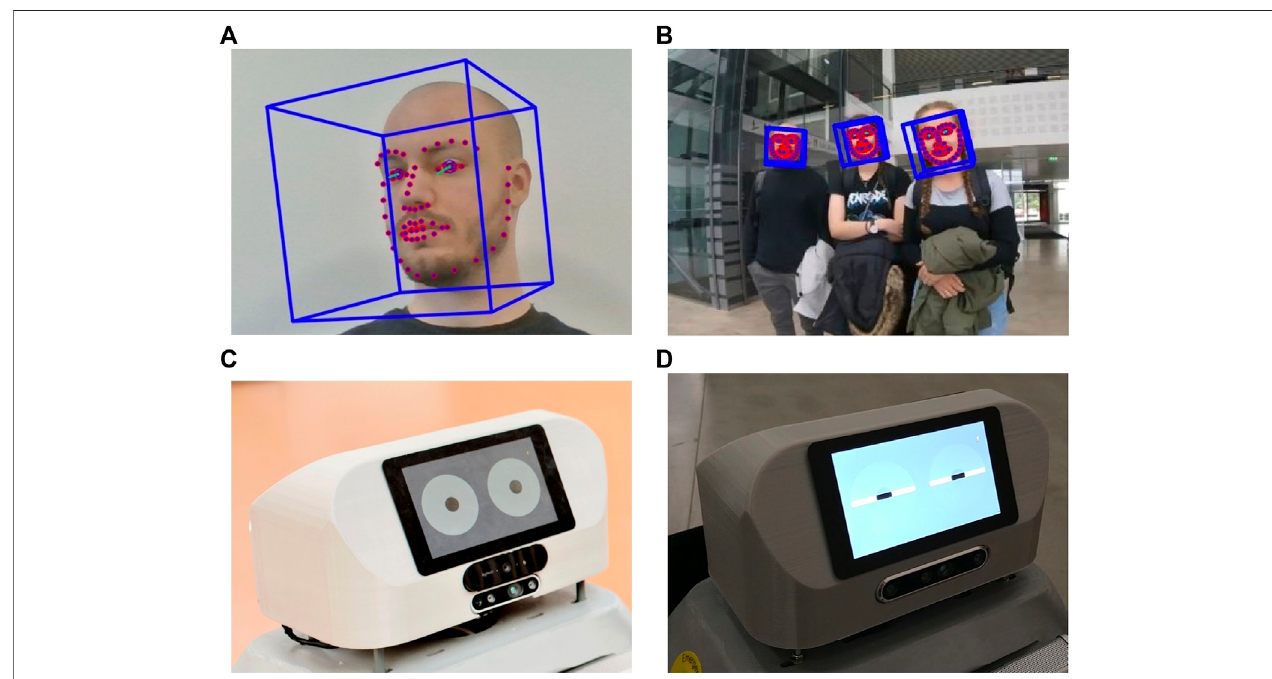
FIGURE 4 | (A) SMOOTH with a tray for holding beverage cups; (B) tray sensor; (C) scenario 1 of beverage delivery use case — robot detects people (yellow arrows), identi fi es groups among them, adds costmaps around detected people and groups (pink color), and plans approach points for serving beverages (red arrows); (D) robot approaching groups of people in a sparse reception scenario.